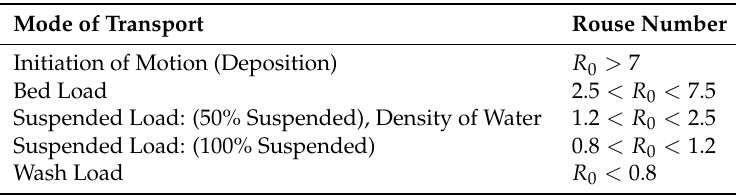
Table 2. Modes of transport according to the Rouse number